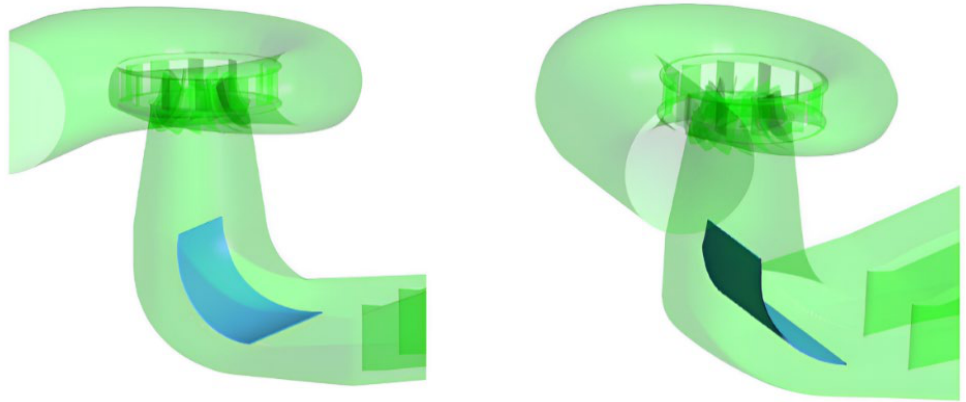
Figure 14. Installation of diversion plate at elbow